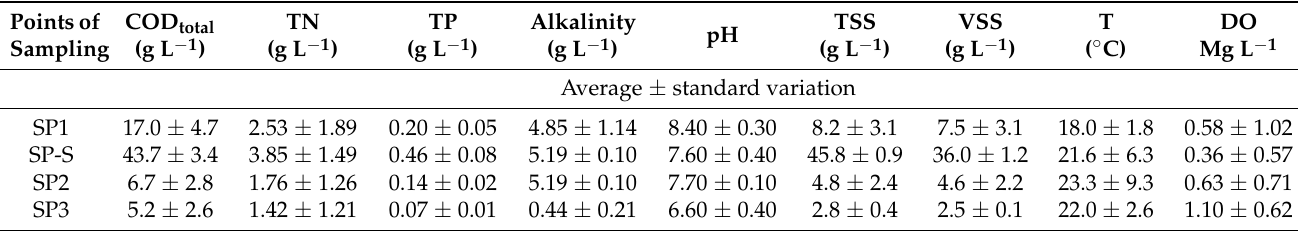
Table 1. Characteristics of the blackwater system in different treatment modules: blackwater (SP1), sludge from the UASB reactor (SP-S), anaerobic digested blackwater (SP2) and effluent from the tubular PBR (SP3). Points of COD total Sampling (g L − 1